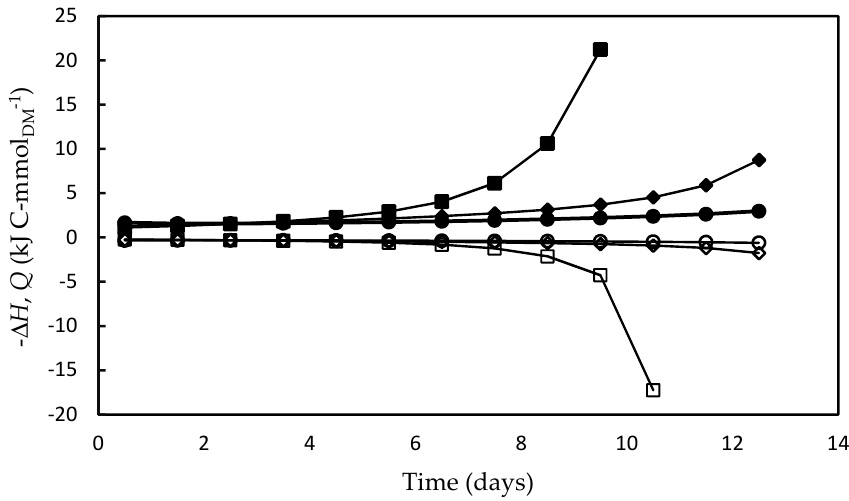
, • ), Alternative medium ( , (cid:117) ). (cid:35) (cid:51)